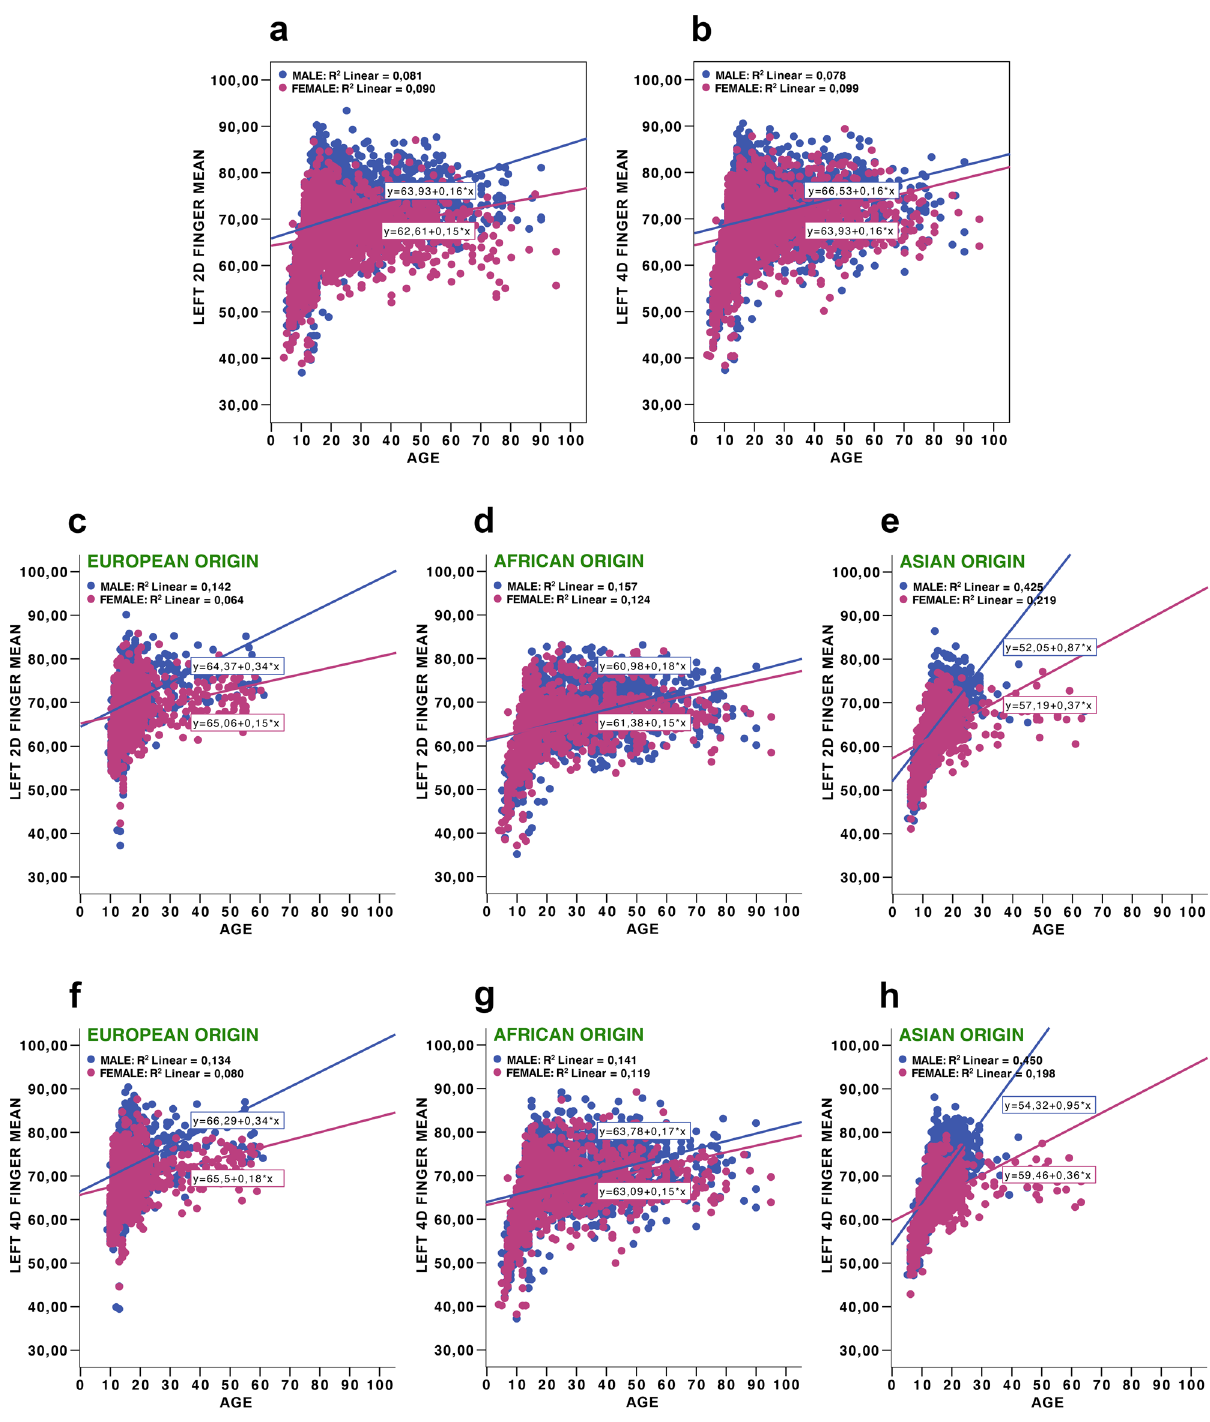
Figure 3. Left 2D and 4D finger means to age: left 2D finger means to age in total sample ( a ), left 4D finger means to age in total sample ( b ), left 2D finger means to age in three populations (European origin ( c ), African origin ( d ), Asian origin ( e )), left 4D finger means to age in three populations (European origin ( f ), African origin ( g ), Asian origin ( h